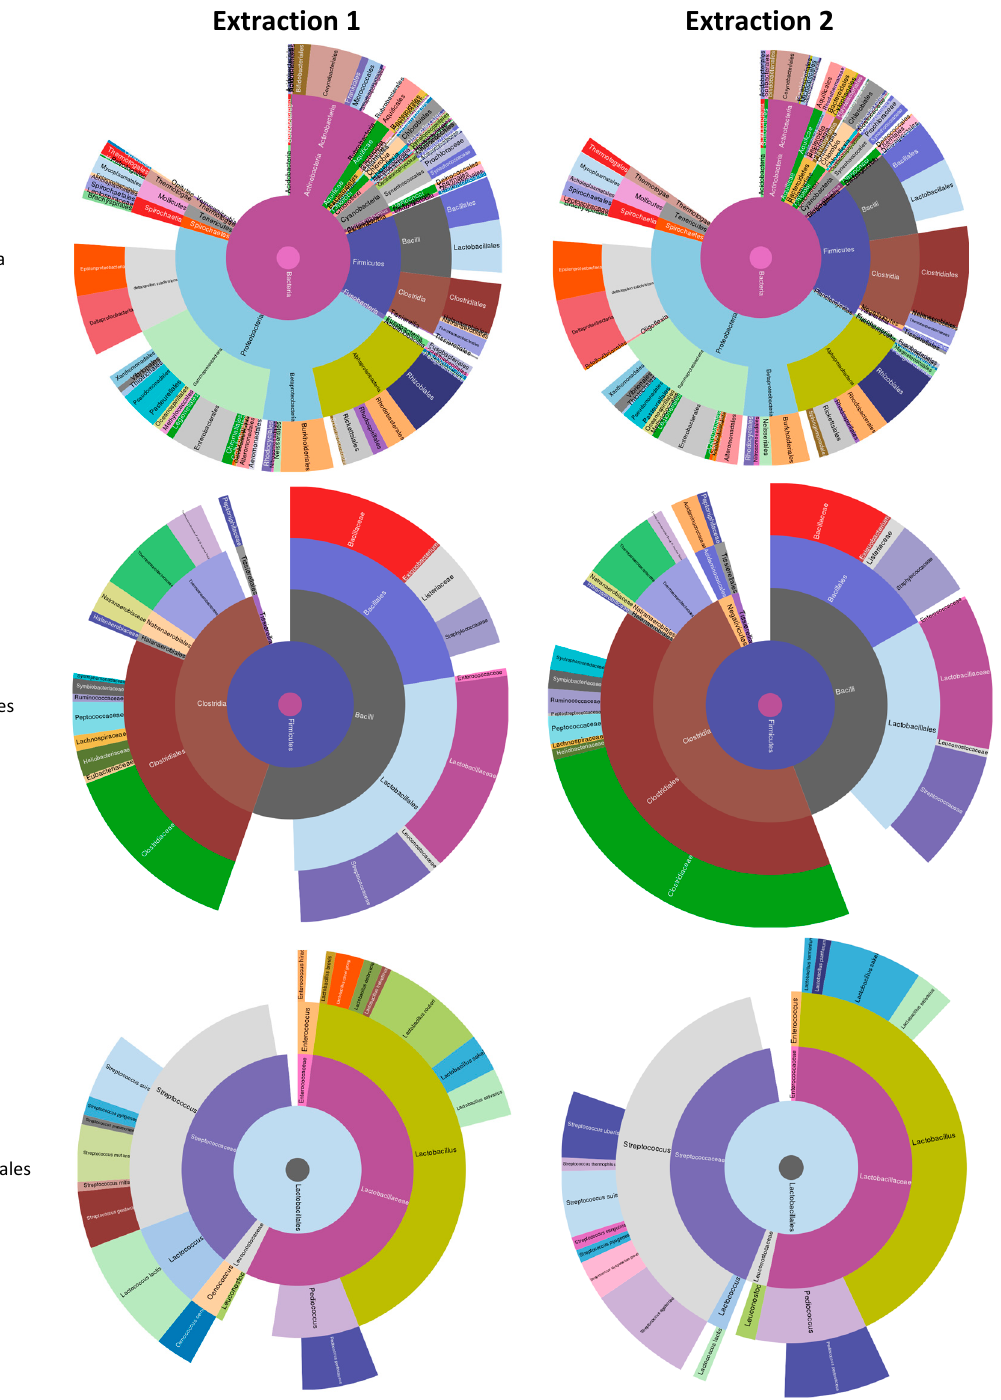
Figure 2. Metaproteomics (Unipept) analysis at the level of the Bacteria domain, Firmicutes phylum, and Lactobacillales order obtained using the peptides identified by searching against the UniProt database restricted to all reviewed bacterial